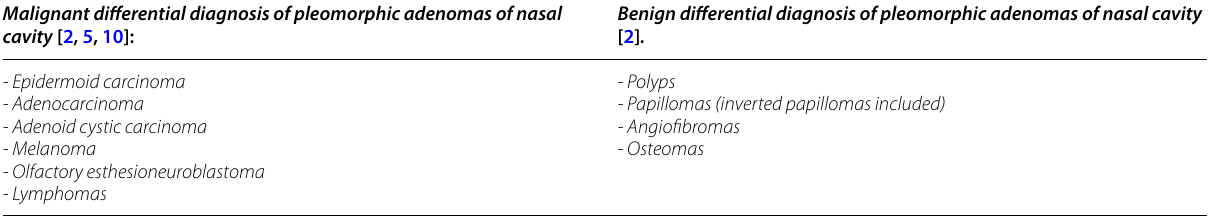
Table 1 Differential diagnosis of pleomorphic adenoma: benign and malignant tumors. Macroscopic aspect [2, 5, 10] Malignant differential diagnosis of pleomorphic adenomas of nasal cavity [2, 5, 10]: